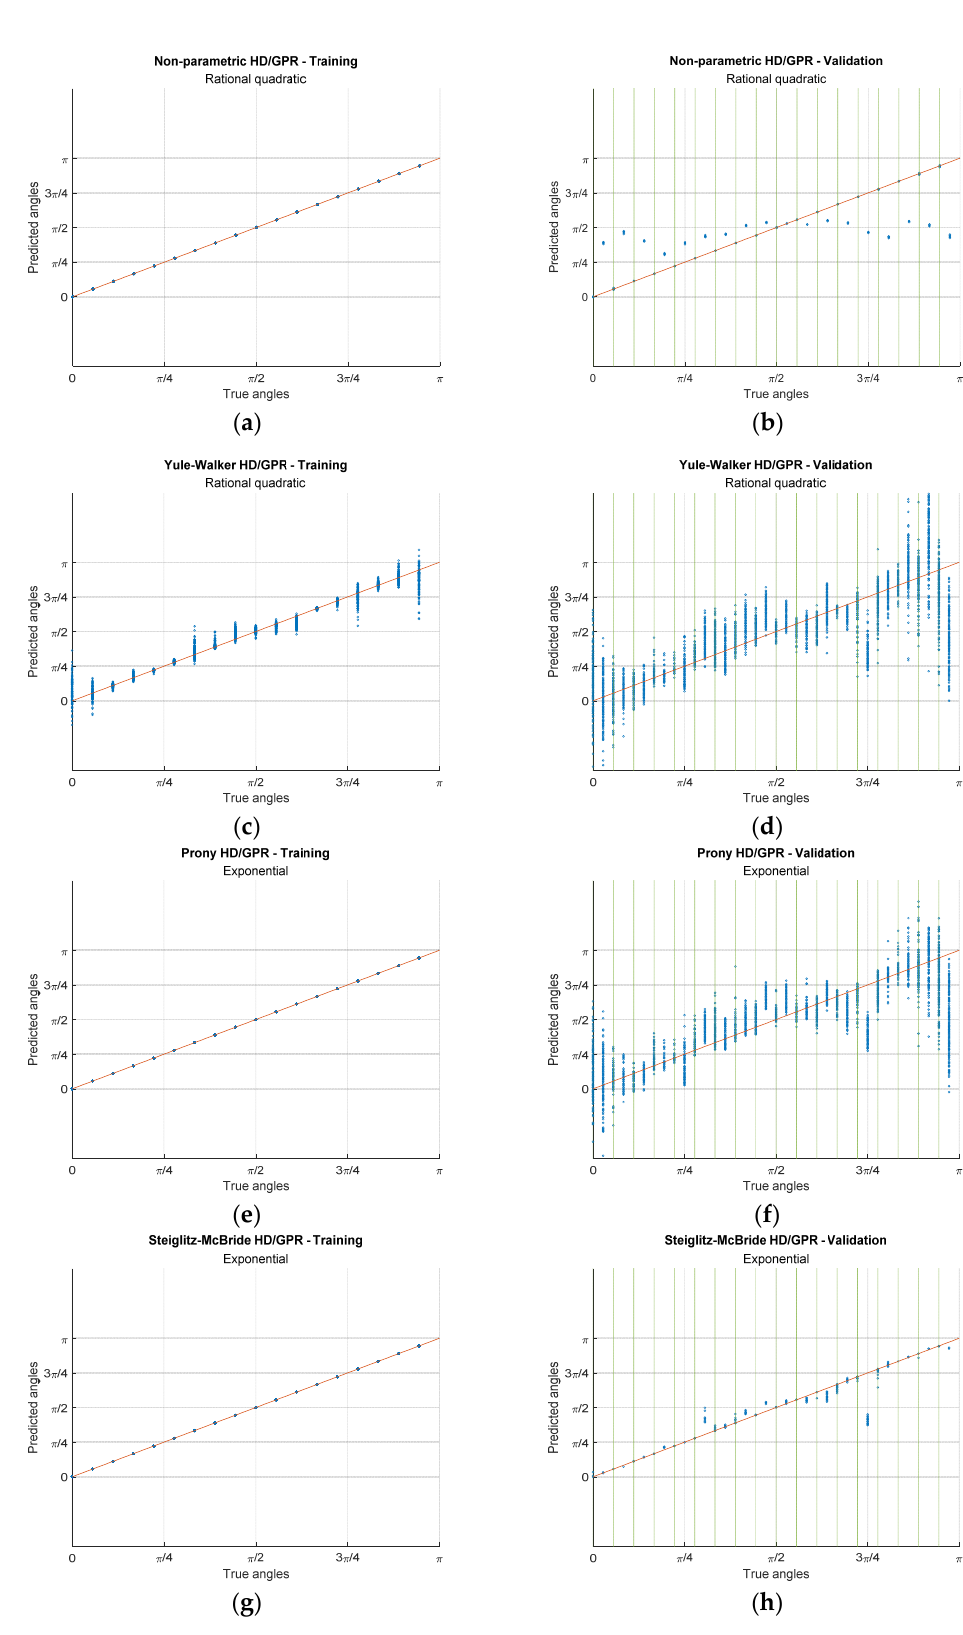
Figure 12. Actual predictions for training and validation from simulation. The iteration numbers are identical to Figures 9 and 10 caption. The green vertical lines show the seen angles. ( a , b ) Non-parametric HD/GPR—Training and Validation; ( c , d ) Yule–Walker HD/GPR—Training and Validation; ( e , f ) Prony HD/GPR—Training and Validation; ( g , h ) Steiglitz–McBride HD/GPR—Training and Validation.